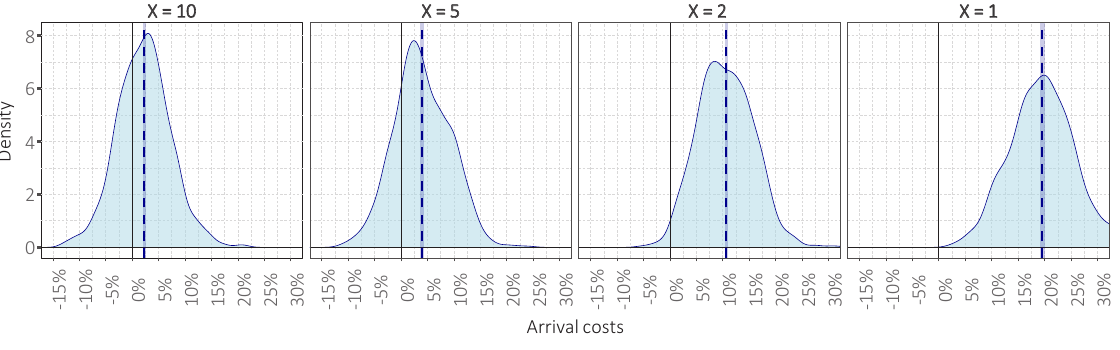
Figure 4. Arrival cost distribution for various frequencies of metaorder trading